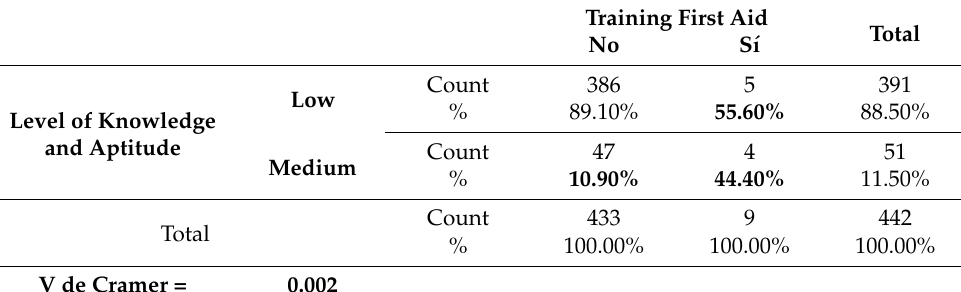
Table 7. Level of knowledge and aptitude according to training received in relation to first aid measures in dental